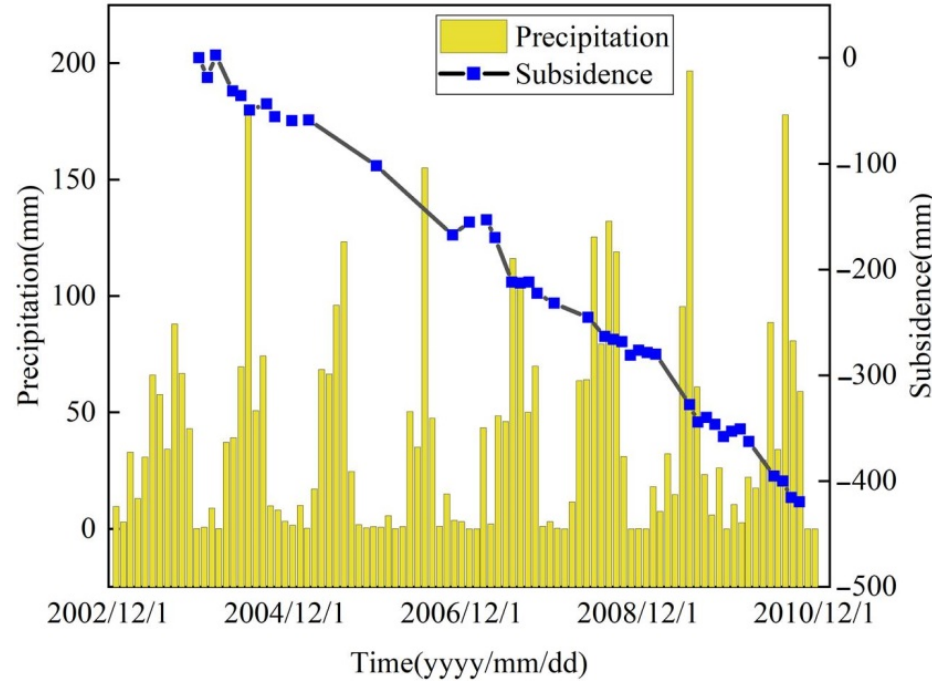
Figure 14. Changes in precipitation from 2003 to 2010.